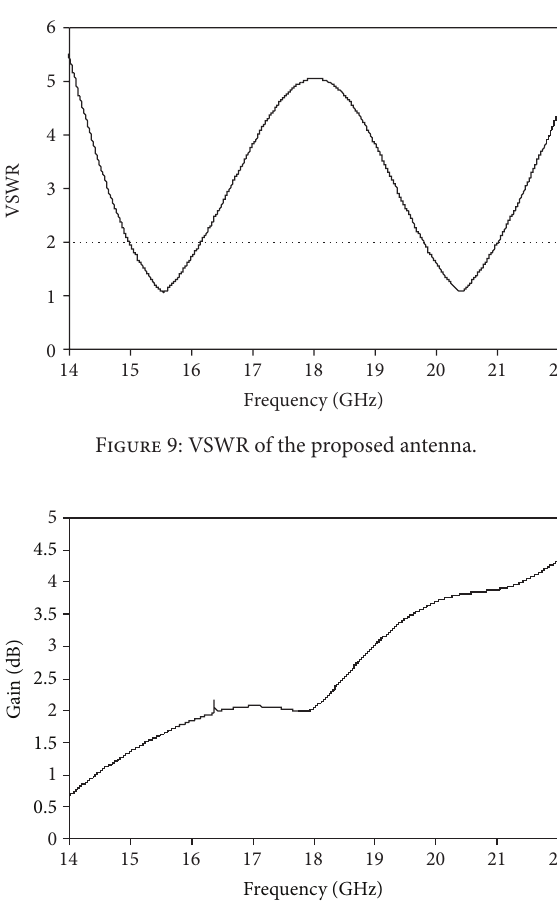
Figure 10: Gain of the proposed antenna.